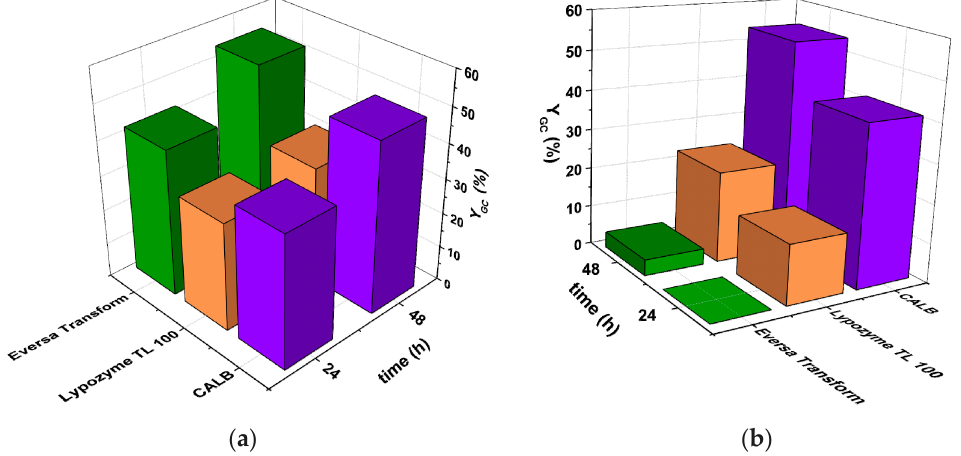
Figure 1. Glycerol carbonate yields using lipases CALB, Lypozyme TL 100 L and Eversa Transform in the transesterification of glycerol with ( a ) EC and ( b ) DMC. Type of reactor: batch closed system; T = 60 °C ; Carbonate: Gly = 2:1; enzyme concentration: 3% v / v ; solvent: tert-butanol (30% v / v ) agitation speed: 400 rpm.